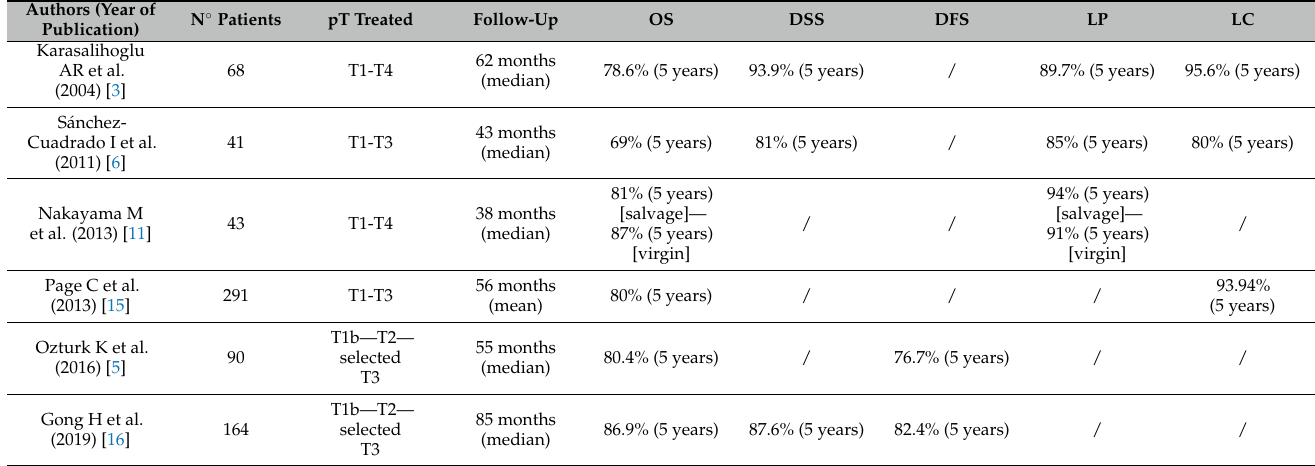
Table 1. Primary OPHL type II: characteristics of included studies.